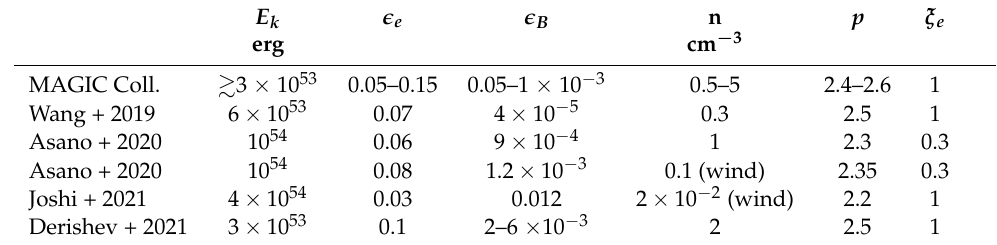
Table 2. GRB190114C: parameters inferred by different authors from the modeling of observations with a synchrotron-SSC scenario. E k (cid:101) e (cid:101) B n p ξ e erg cm − 3 MAGIC